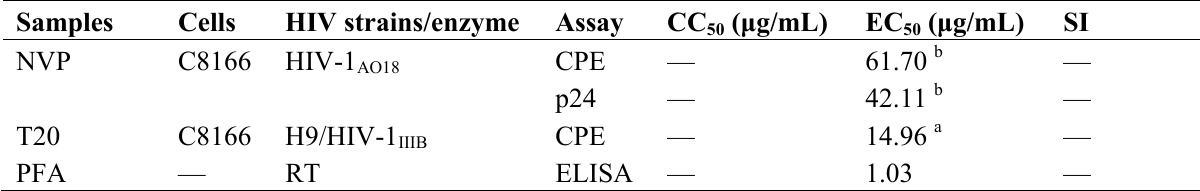
, HIV-1 , IIIB RF , HIV-1 , HIV-1 and IIIB RF A17